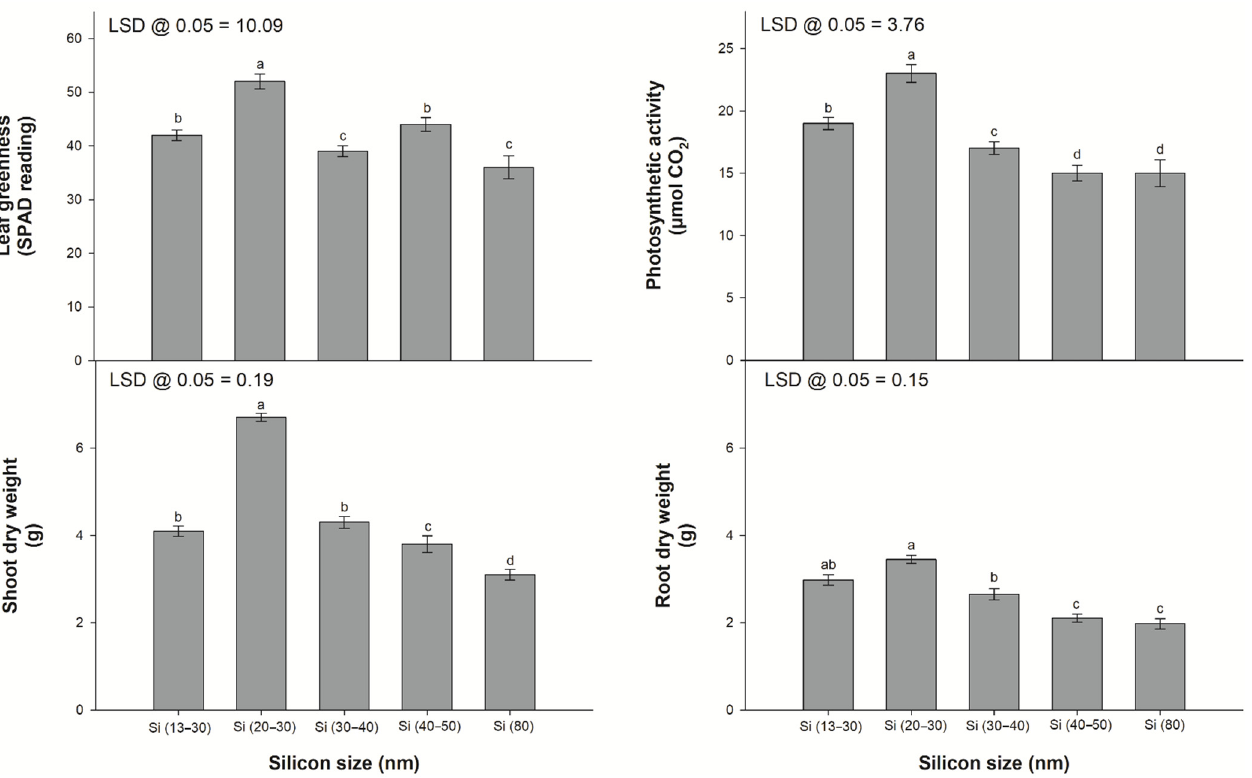
Figure 1. Effect of silicon nanoparticles of different sizes on leaf greenness, photosynthetic activity, and root/shoot plant biomass. Nanoparticles were foliar applied at the rate of 250 ppm two times in a week, and data were collected 10 days after application. Values are mean of four independent replicates ( n = 4) ± SE (shown in vertical bars), and values denoted by different letters (in small alphabets) differ significantly at p < 0.05, using the LSD